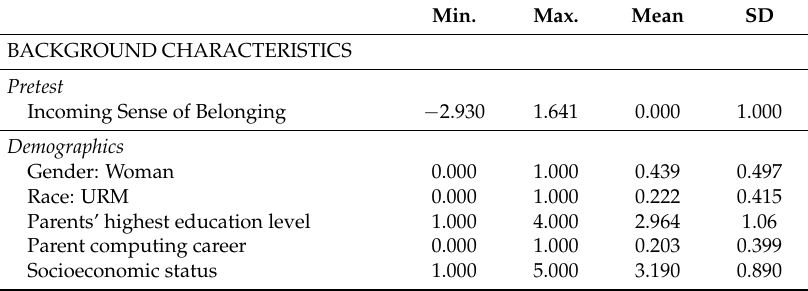
Table A1. Descriptive Statistics for Independent